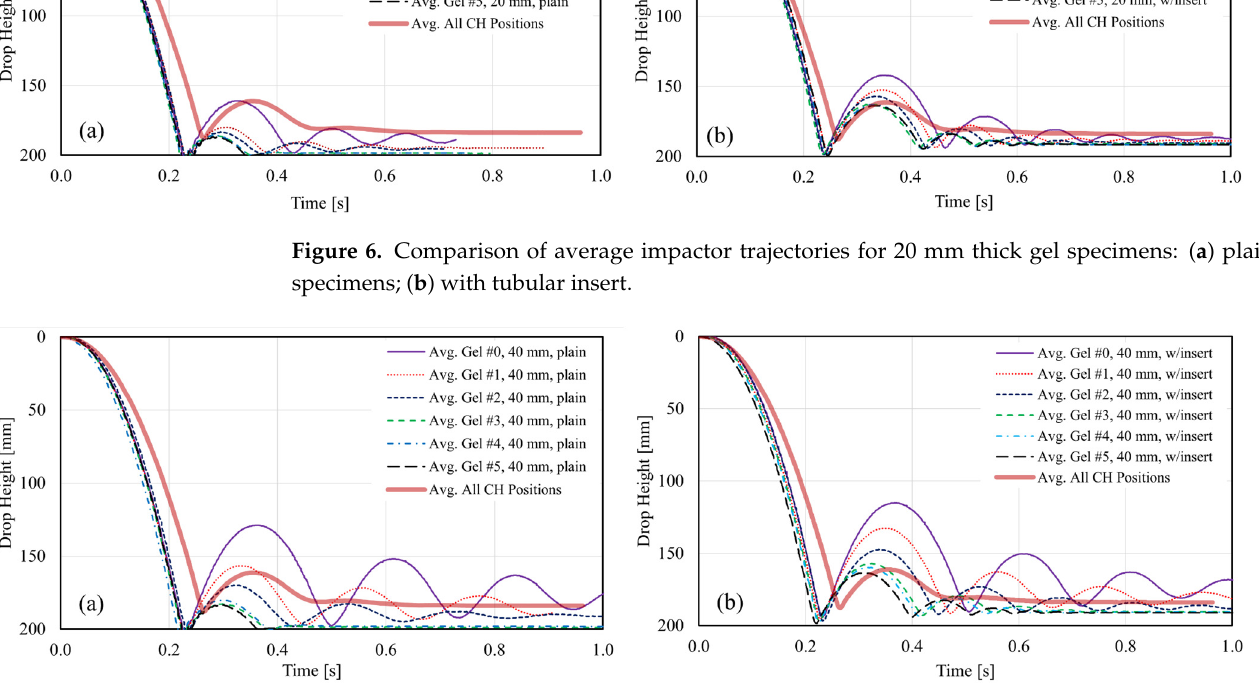
Figure 7. Comparison of average impactor trajectories for 40 mm thick gel specimens: ( a ) plain specimens; ( b ) with tubular insert.